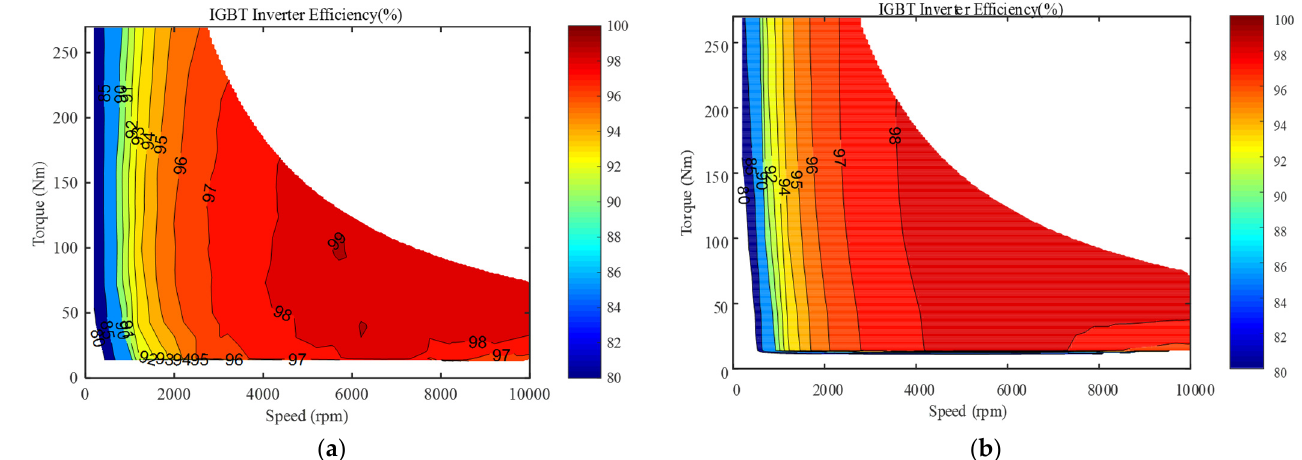
Figure 3. Efficiency map of the IGBT inverter with ( a ) measured and ( b ) calculated results.